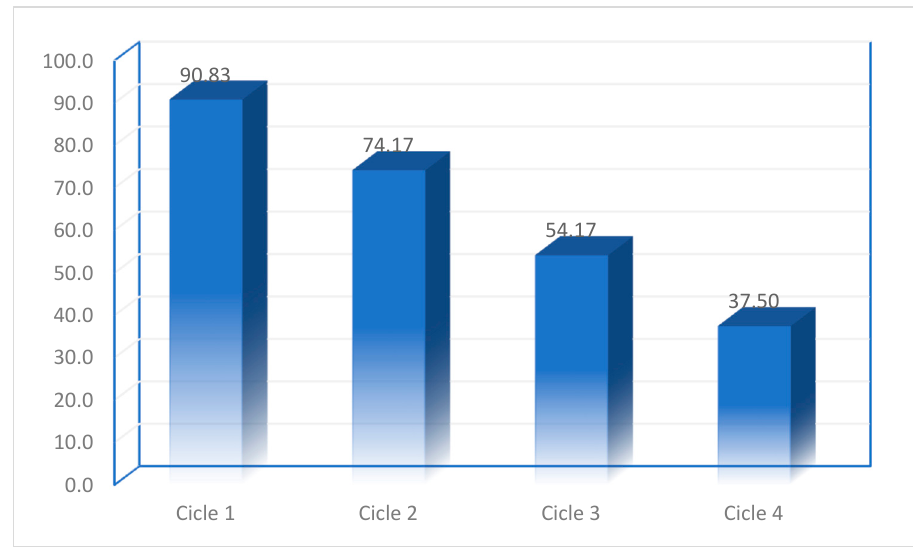
Figure 13. Regeneration degree of adsorbent.